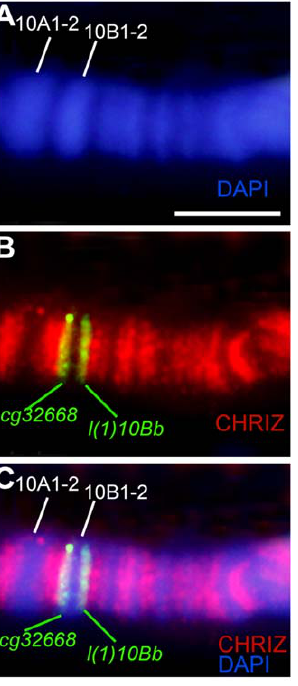
Figure 5. Colocalization of DNA probes limiting the band 10B1–2, and Chriz/CHRO protein. Banding pattern in the region 10A–B (DAPI) ( A ), immunostaining of Chriz/CHRO and FISH of the DNA probe ( A ), immunostaining of Chriz/CHRO, FISH of the DNA probe and DAPI ( C ). Bar represents 5 m m.